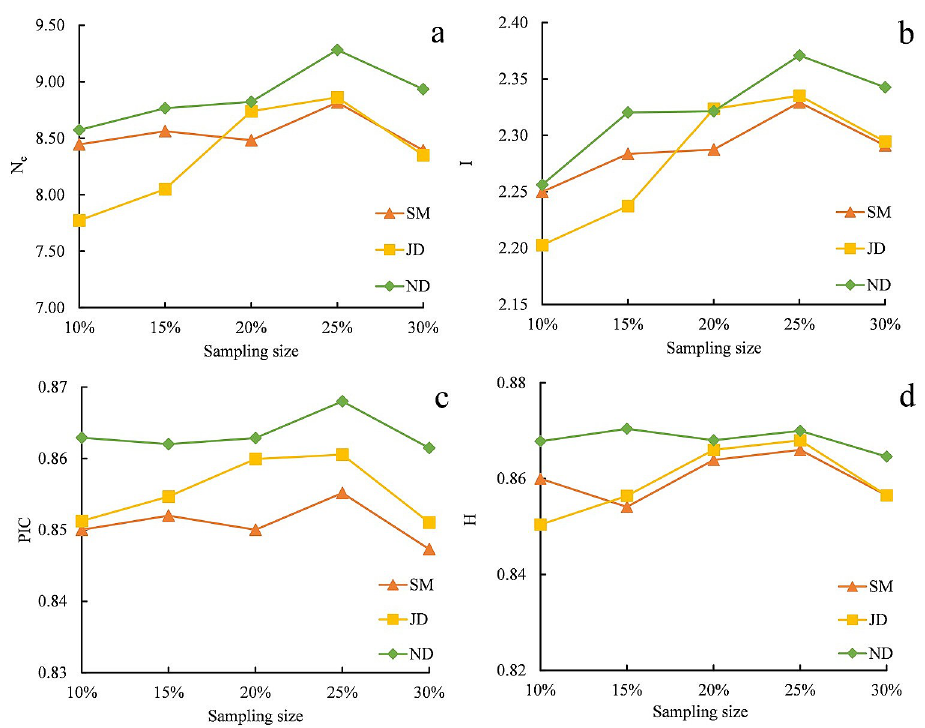
Fig 1. Values of N e , I, PIC and H of core subset based on different sample size and different genetic distance with allele preferred strategy. ND: Genetic distance using Nei & Li genetic similarity coefficient, SM: Genetic distance using simple matching coefficient, JD: Genetic distance using Jaccard genetic similarity coefficient, N E : Number of effective alleles, I: Shannon’s information index, PIC: Polymorphic information content, H: Nei’s gene diversity.